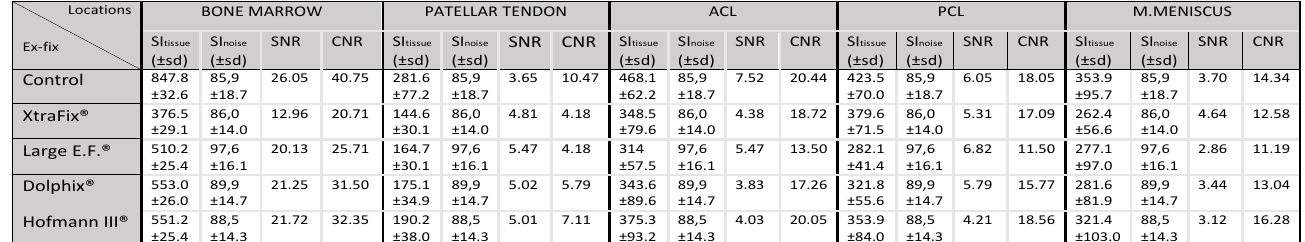
Figure 2. Values of Signal Intensity of tissue (SItissue), Signal Intensity of noise (SInoise), Signal to Noise (SNR), and Contrast to Noise (CNR) in the different regions of interest (ROIS) stratified for devices.